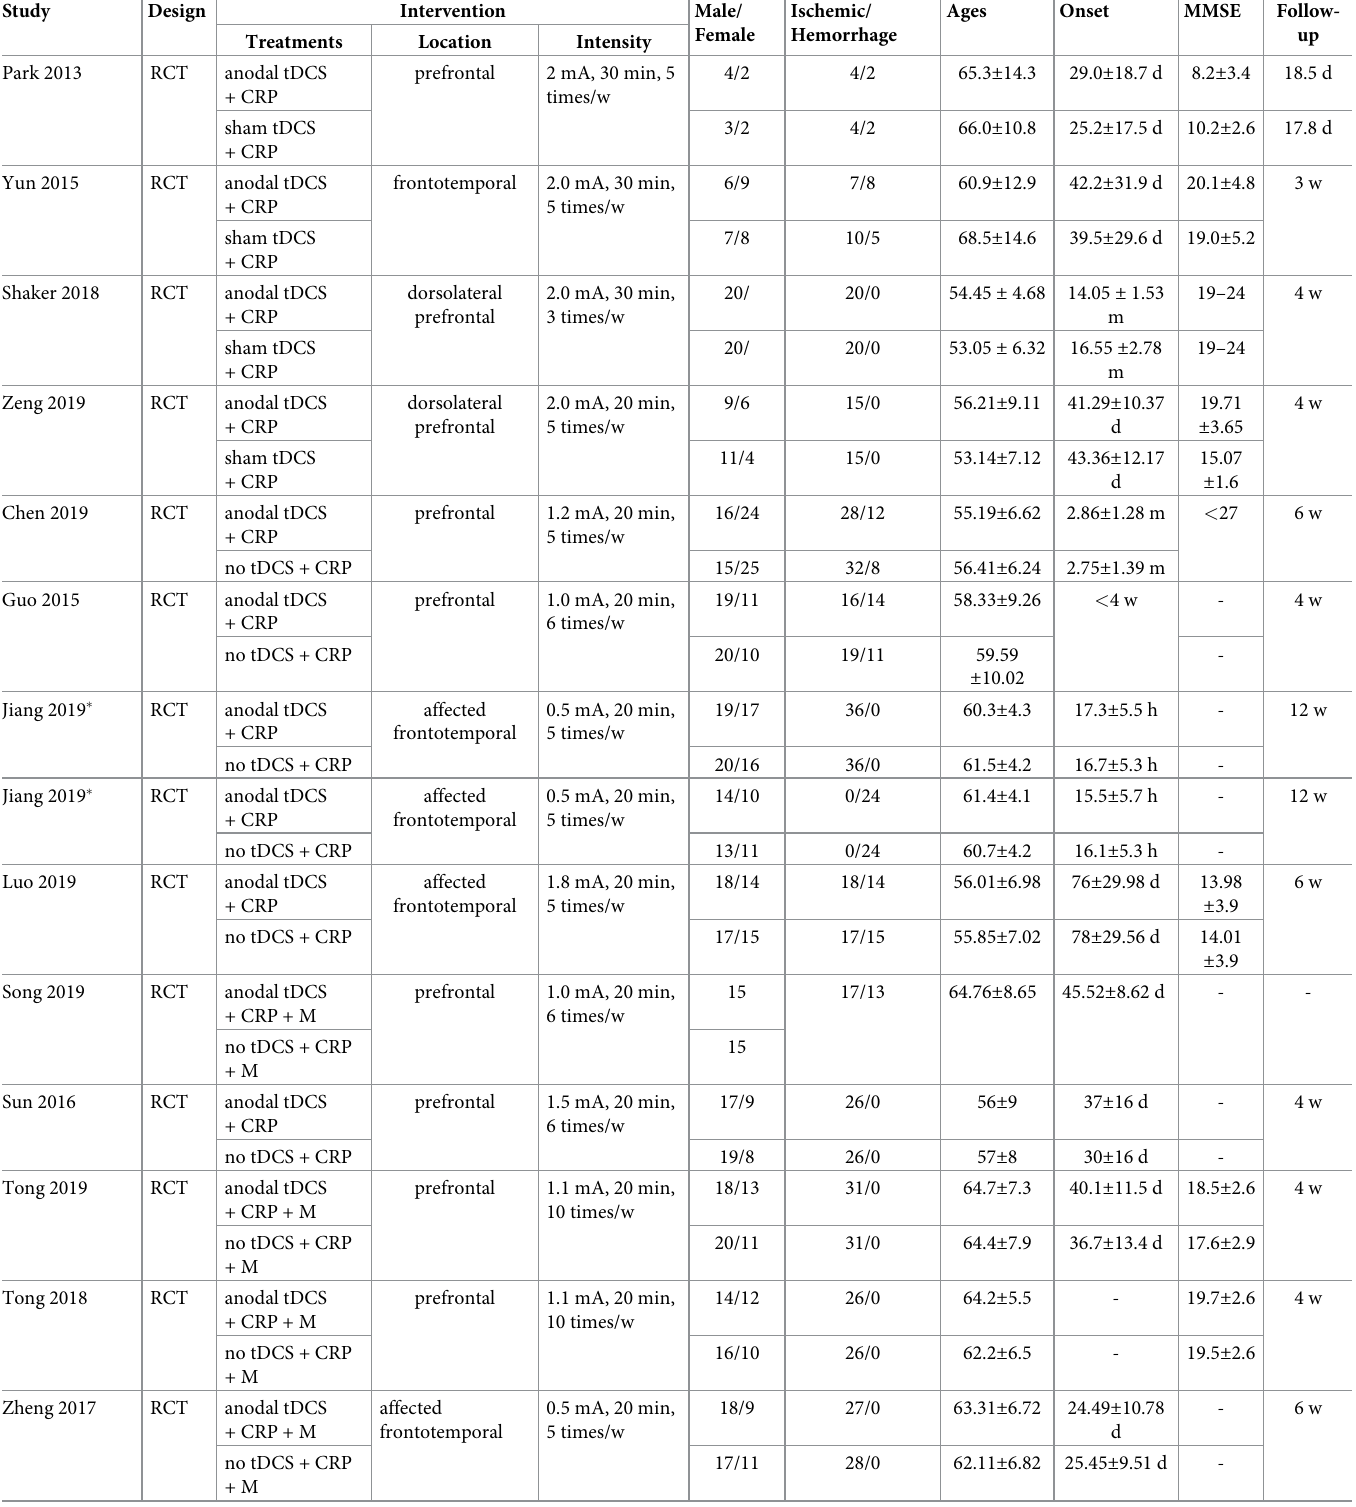
Table 1. Characteristics of the included studies and patients.